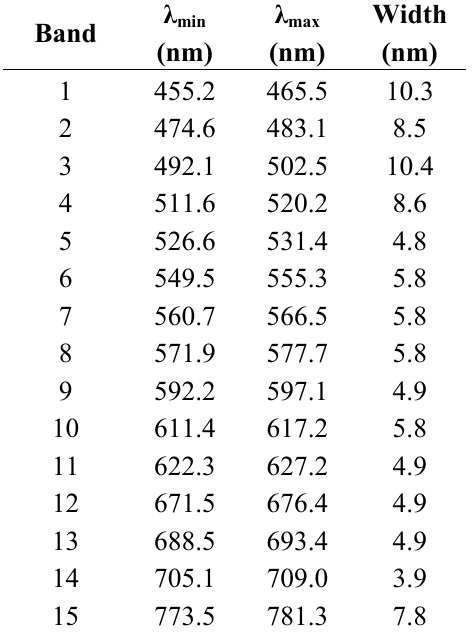
Table 1. Band wavelengths for modelled sensor. In each band sensitivity is considered uniform from λ to λ , consistent with Compact Airborne Spectrographic Imager min max (CASI) configuration where each band is composed of several wavelength-contiguous sensor